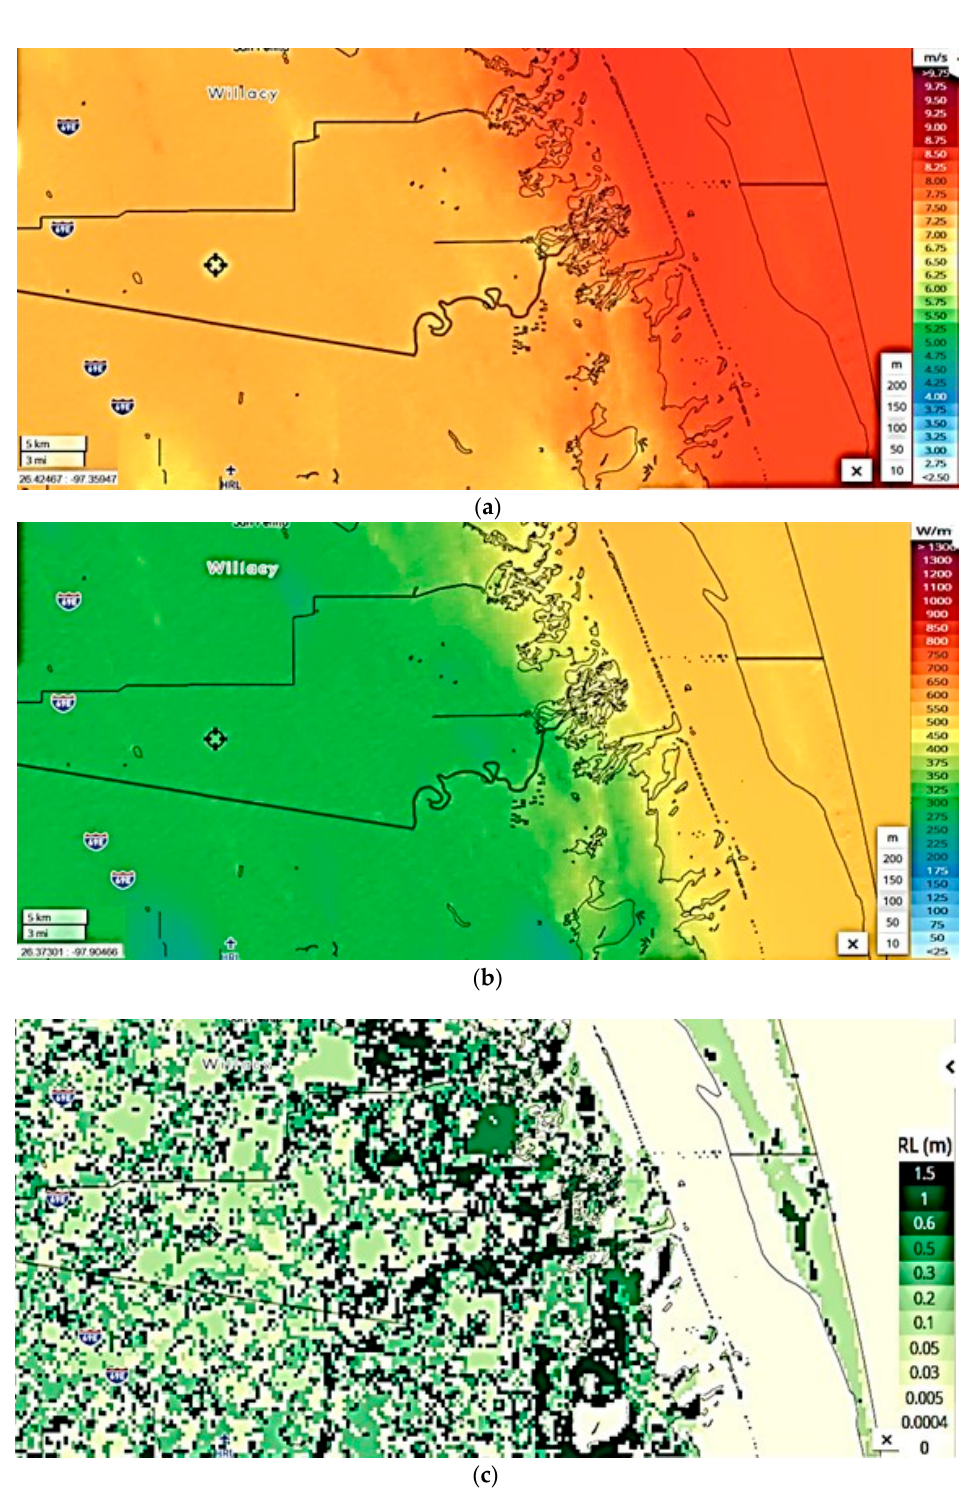
Figure 2. Location of the Los Vientos (LV) WEF, and reference wind speed, power density, and roughness. ( a ) Mean wind speed at 100 m height, ( b ) mean power density at 100 m height, and ( c ) roughness length. The location of the facilities is indicated at 26.363, − 97.671. Images reproduced are modified after [53]. The area of the facilities is characterized by about the same wind energy resource and orography.